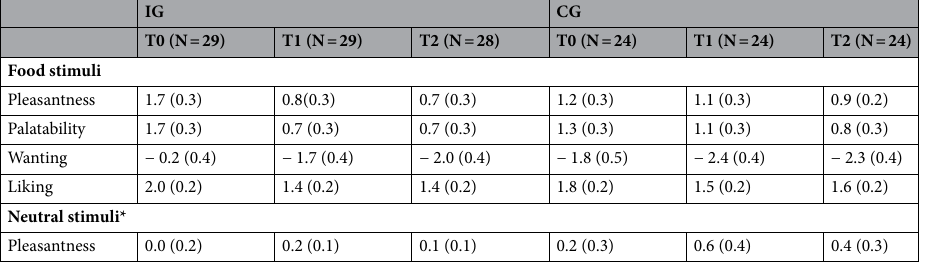
Table 2. Stimuli ratings (M, SE) of the food and neutral stimuli by treatment group (IG, CG) and measurement point (T0, T1, T2). The food and neutral stimuli were rated on a Likert scale ranging from − 5 to + 5. Significant effects are presented in the main text. *The table displays the original values though the General Estimating Equations for the neutral stimuli were computed with symmetrically logarithmised values to achieve normal